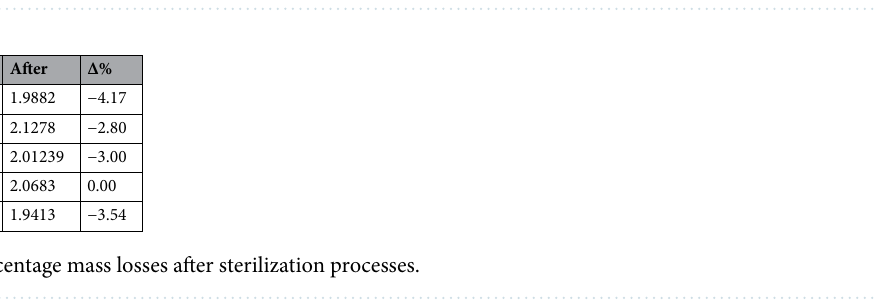
Table 1. Percentage mass losses after sterilization processes.